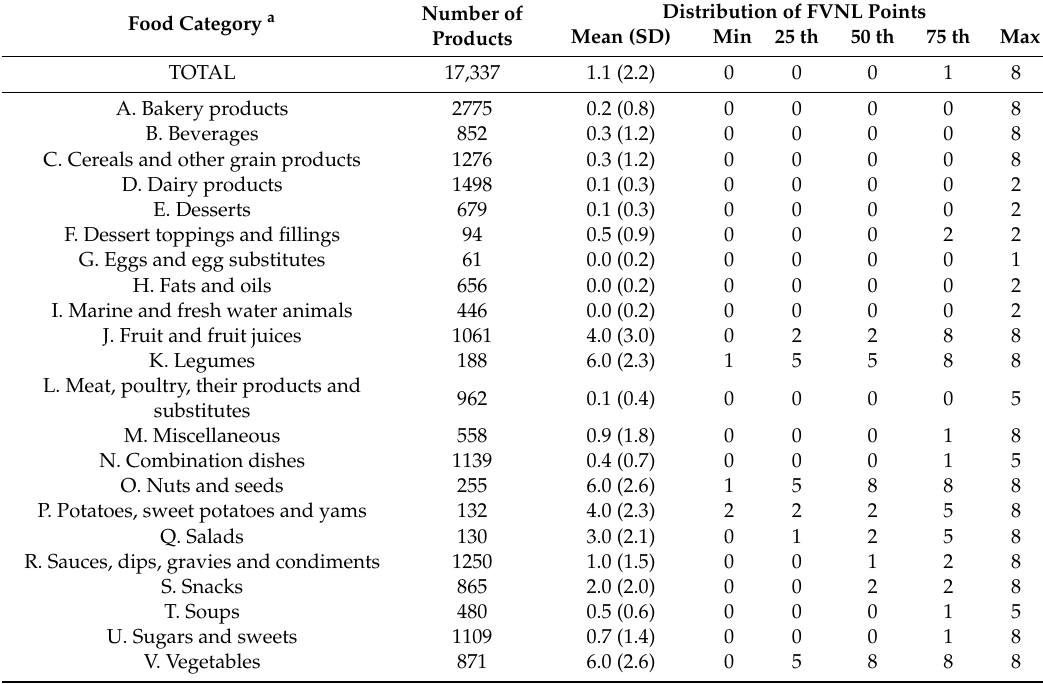
Table 3. Distribution of fruit, vegetable, nut and legume (FVNL) points in Canadian packaged foods and beverages, as defined by the Food Standards Australia New Zealand Nutrient Profiling Scoring Criterion and the Health Star Rating system, presented for the total sample and by food category a